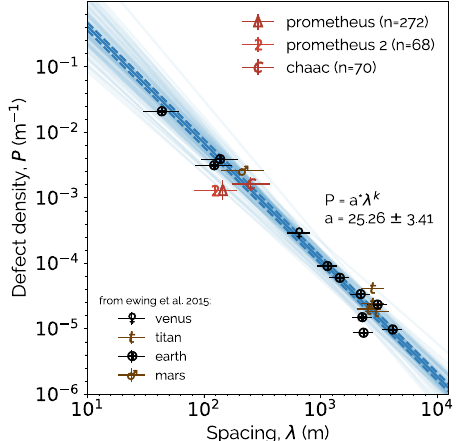
Fig. 5 Dune defect density vs crest spacing across planetary bodies. The measurements from this work for Io are compared with the power law trend fi t to observations on other planetary bodies 29 . The number of ridges measured at each site on Io are denoted by n . The calculation method for the error bars are described in the “ Ridge crest digitization ” and “ Best- fi t trendline for defect density to crest spacing ratio ” sections of Methods. Our maximum likelihood fi t to the data from other bodies (see Methods) is shown as the thick, dark blue line, with the intrinsic 1 σ scatter of that trend indicated by the dashed lines. The best fi t parameters are shown. The thin, transparent lines are a sample of less likely fi ts. Posterior probability distributions for the fi t parameters are shown in Supplementary Fig. 5.